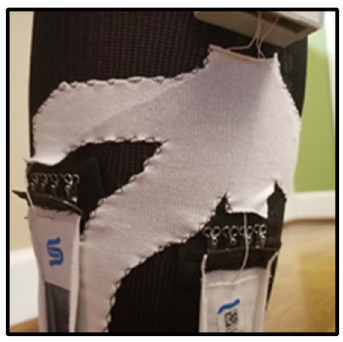
Figure 11. Hook and eye attachment to hold SRS in place.